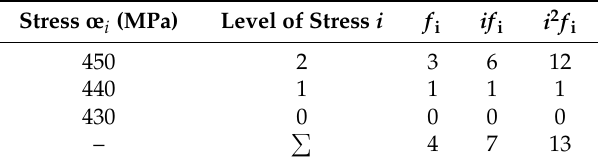
Table 4. Data analysis for modified staircase method.